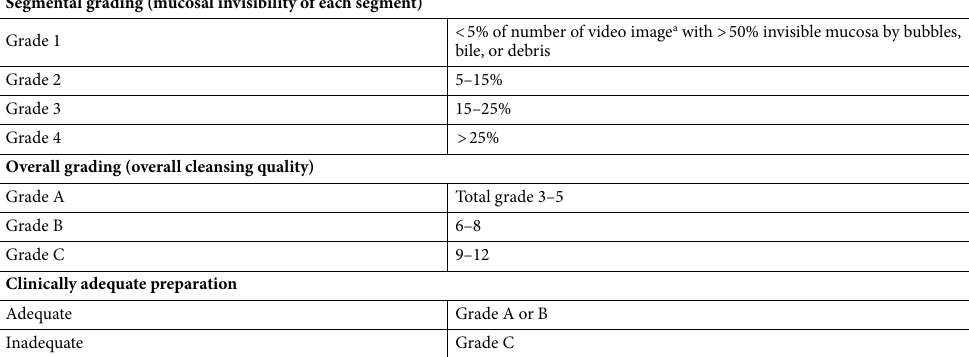
Table 1. A validated small bowel preparation scale using a quantitative parameter. a Still-cut image (frame).